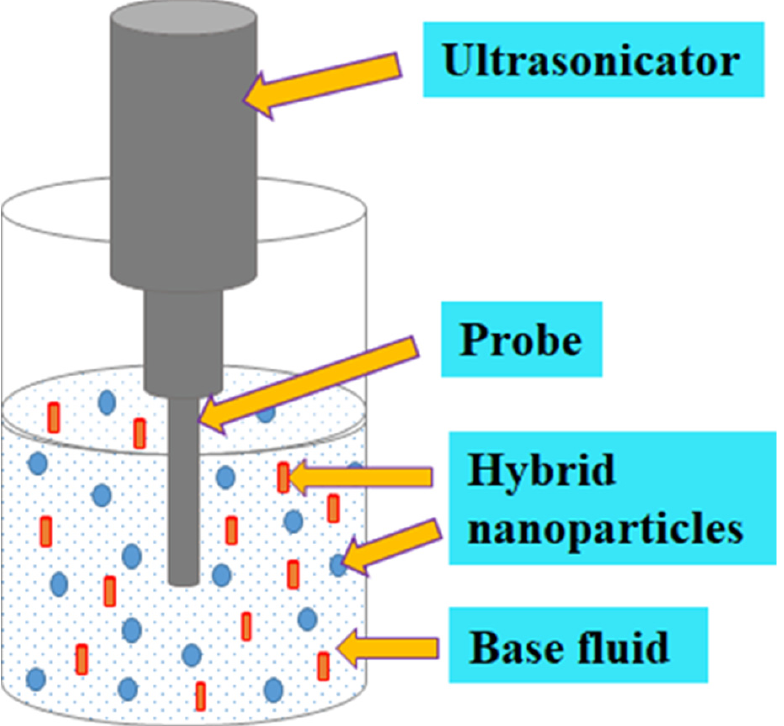
Figure 3. Ultrasonication of HNF.